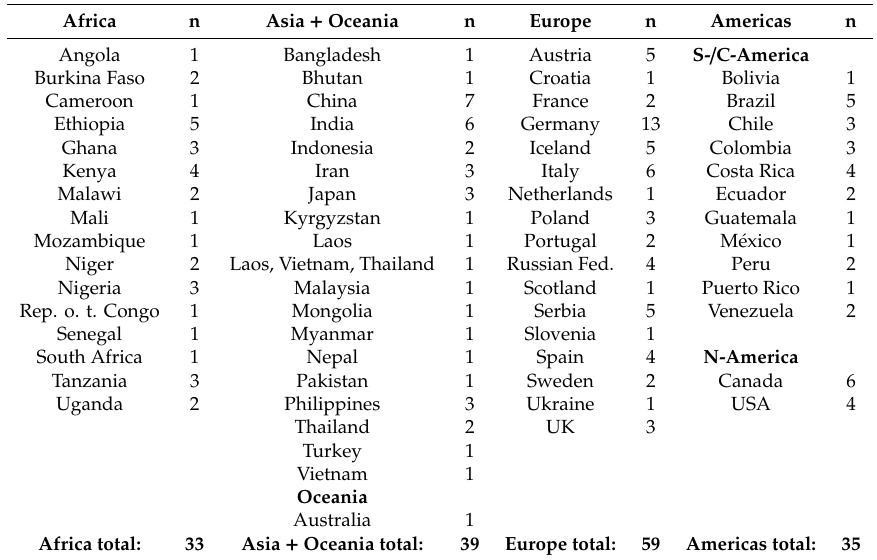
Table 1. Number of respondents by project country and